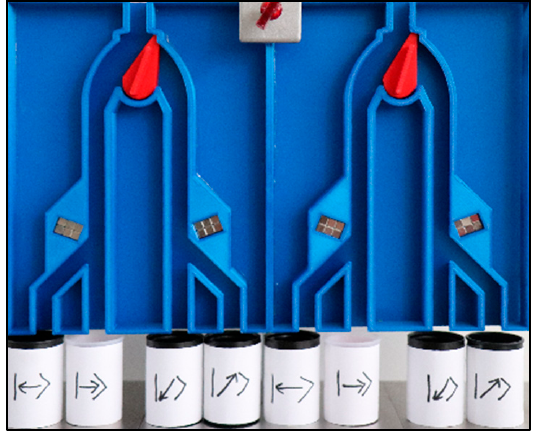
Figure 3. 3D-printed box with two-way connections. The left part represents Alice’s measurement device; the right one, Bob’s. The red handles each determine the orientation of the Stern–Gerlach experiment (the right path leads to a measurement in the θ 1 direction, the left in the θ 2 direction). Magnets at the bifurcation points guarantee the predetermined result for magnetizable balls. See text for details.